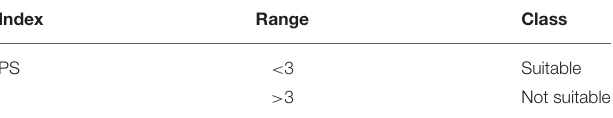
TABLE 7 | Classification of groundwater quality based on